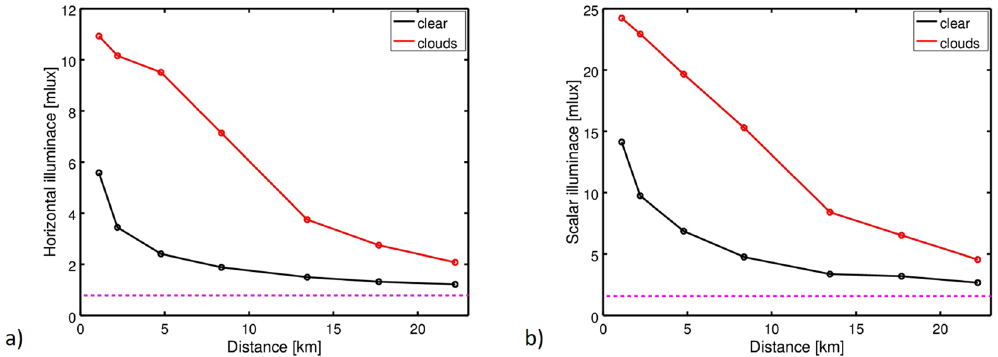
Figure 3. ( a ) Horizontal and ( b ) scalar (hemispheric) illuminance as a function of the distance from the city center of Balaguermeasured for two different nights with clear sky (black) and partly cloudy sky (red). Magenta lines show estimated ideal values (see